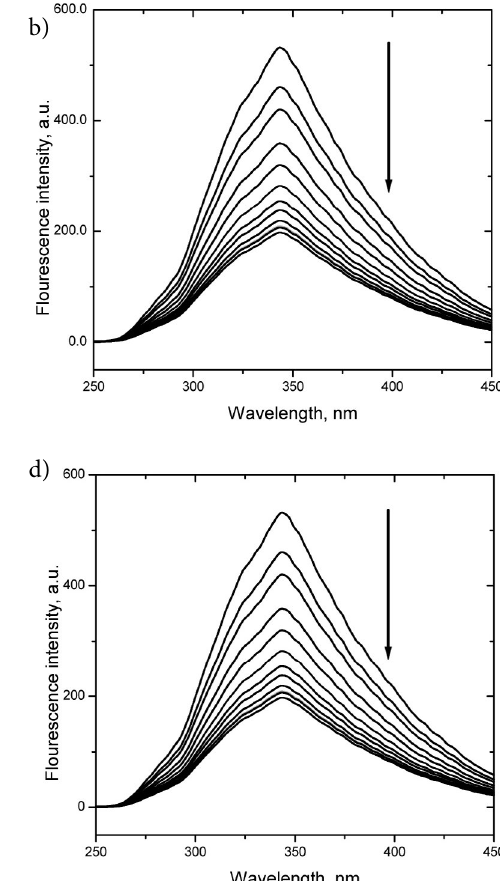
Figure 3. Fluorescence quenching spectra of human serum albumin at various concentrations of nandrolone dissolved in 2 % [BMIM]BF 4 ionic Liquid, [HSA] = 2 µM, [nandrolone]/ionic liquid were: 0.00, 0.58, 1.15, 1.72, 2.28, 2.83. 3.37, 3.91, 4.44, 4.96, 5.48, 5.99 and 6.50 µM all in phosphate buffer solution 50 mM, 25 mM NaCl, pH = 7.0 at different temperatures: (a) 285K (b) 293 K (c) 303 K and (d) 310 K, λ ex = 280